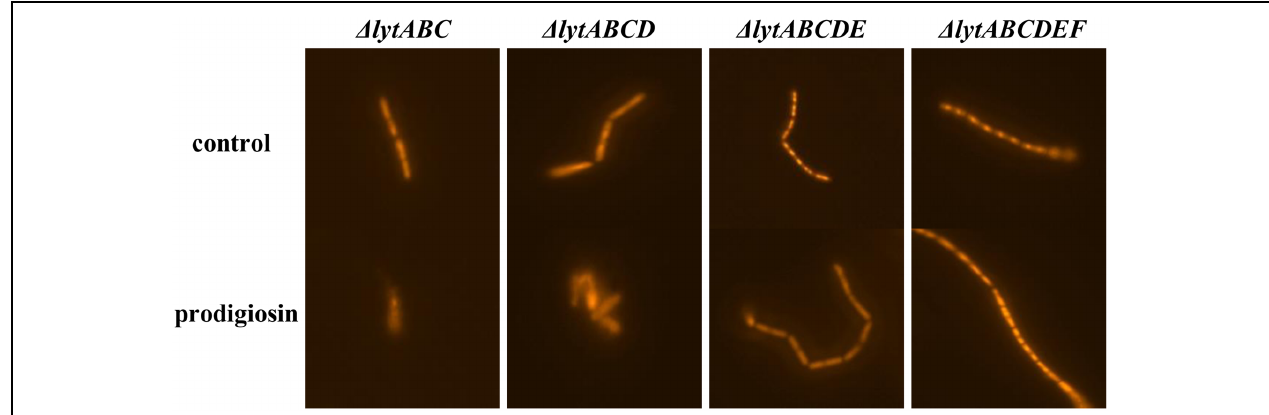
FIGURE 6 | The modified comet assay on different autolysin deficient strains of B. subtilis PS-216 cells grown in LB medium at 37 ◦ C and 200 rpm treated with 0.19% (V/V) of ethanol (control) or treated with 5.9 mg L − 1 of prodigiosin. Cells were treated in the middle exponential phase and were inspected 1 h after the treatment. The gels were stained with GelRedTM. The images were observed with epifluorescent